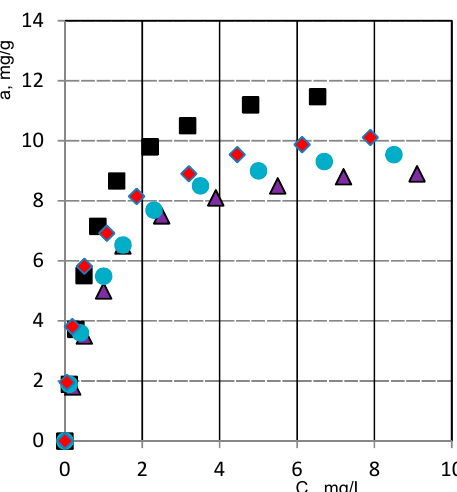
Figure 13. Diazepam adsorption isotherm on activated charcoal from simulated intestinal fluid (SIF) without and with ethanol pH = 6.80 ± 0.05; T = 37.0 with 5% ethanol; • SIF with 10% ethanol; and ▲ SIF with 15% ethanol.